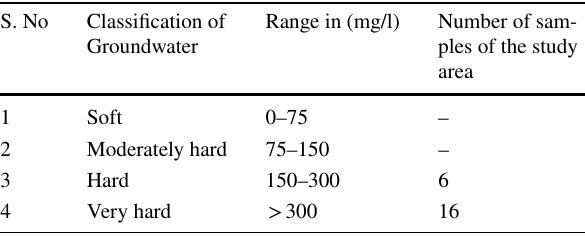
Table 4 Total hardness classification of groundwater quality (Prakash and Somashekar